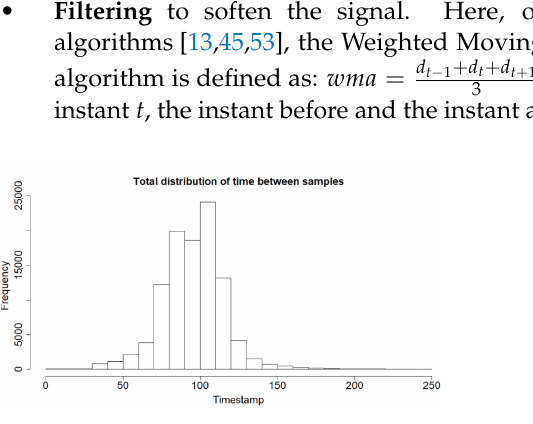
Figure 5. Histogram of the time interval between two consecutive datum. Timestamp is measured in